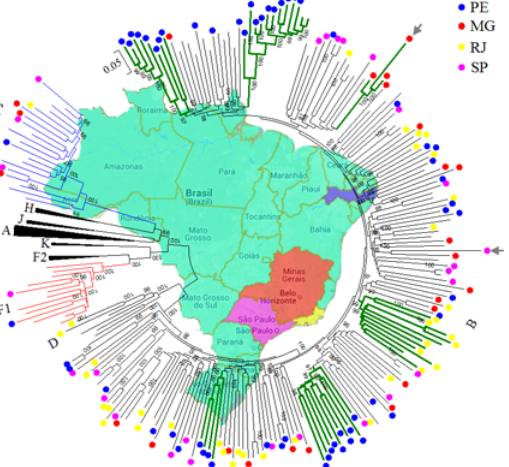
Fig 2. Phylogenetic tree constructed using a ML method from the non-recombinant NFLG sequences of 149 blood donor samples, 53 non-redundant B, eight subclade F1, and eight subtype C sequences from Brazil retrieved from GenBank database. Besides these sequences, the tree also included 37 reference strains (Los Alamos database) representing subtypes A-D, F-H, J and K. Sequences identified in this study are indicated by circles and the geographic origin of each sequence is color-coded. Monophyletic clusters from the same geographic origin are indicated by thick green branches. For clarity purposes, the tree was midpoint rooted. Gray arrows indicate hypermutated sequences with a predominance of unidirectional G-to-A mutations (010BR_MG005, and 010BR_SP022). The aLRT values of at least 80% are indicated at nodes. The scale bar represents 0.05 nucleotide substitutions per